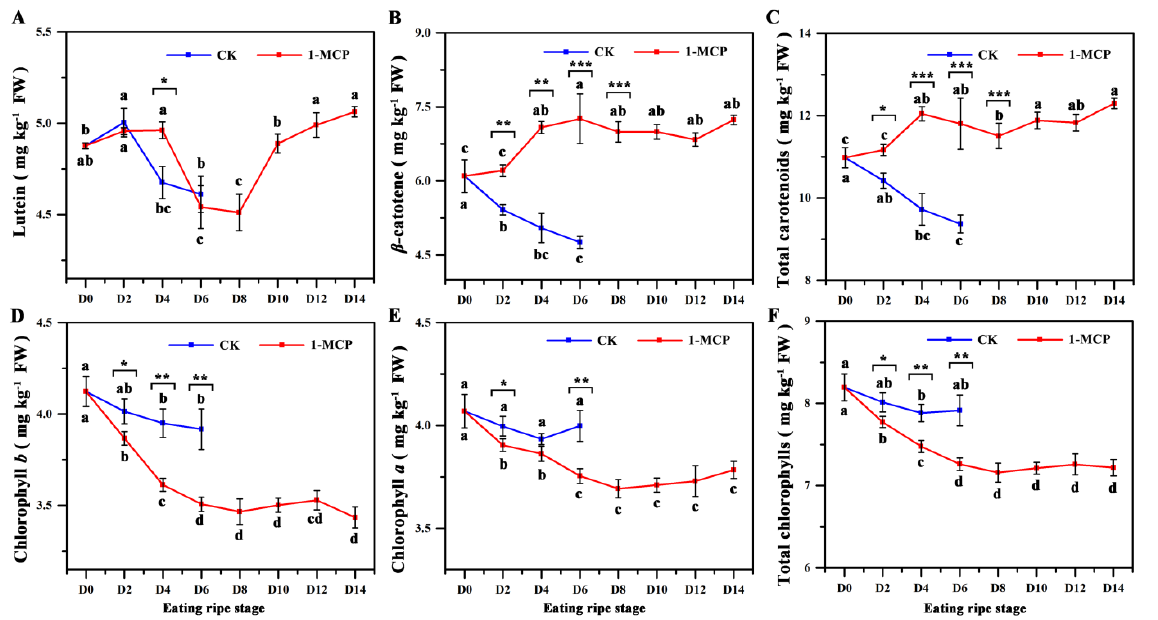
Figure 2. The contents of carotenoid and chlorophyll in treated fruit as measured by HPLC. β -Carotene ( A ), lutein ( B ), total carotenoids ( C ), chlorophylls b and a ( D , E ), and total chlorophylls ( F ). Data are mean ± SE ( n = 3). Different letters represent significant differences in the same group during ripening ( P < 0.05). Asterisk represents a significant difference between the control (CK) and 1-MCP treated fruit (* P < 0.05, ** P < 0.01, *** P < 0.001).